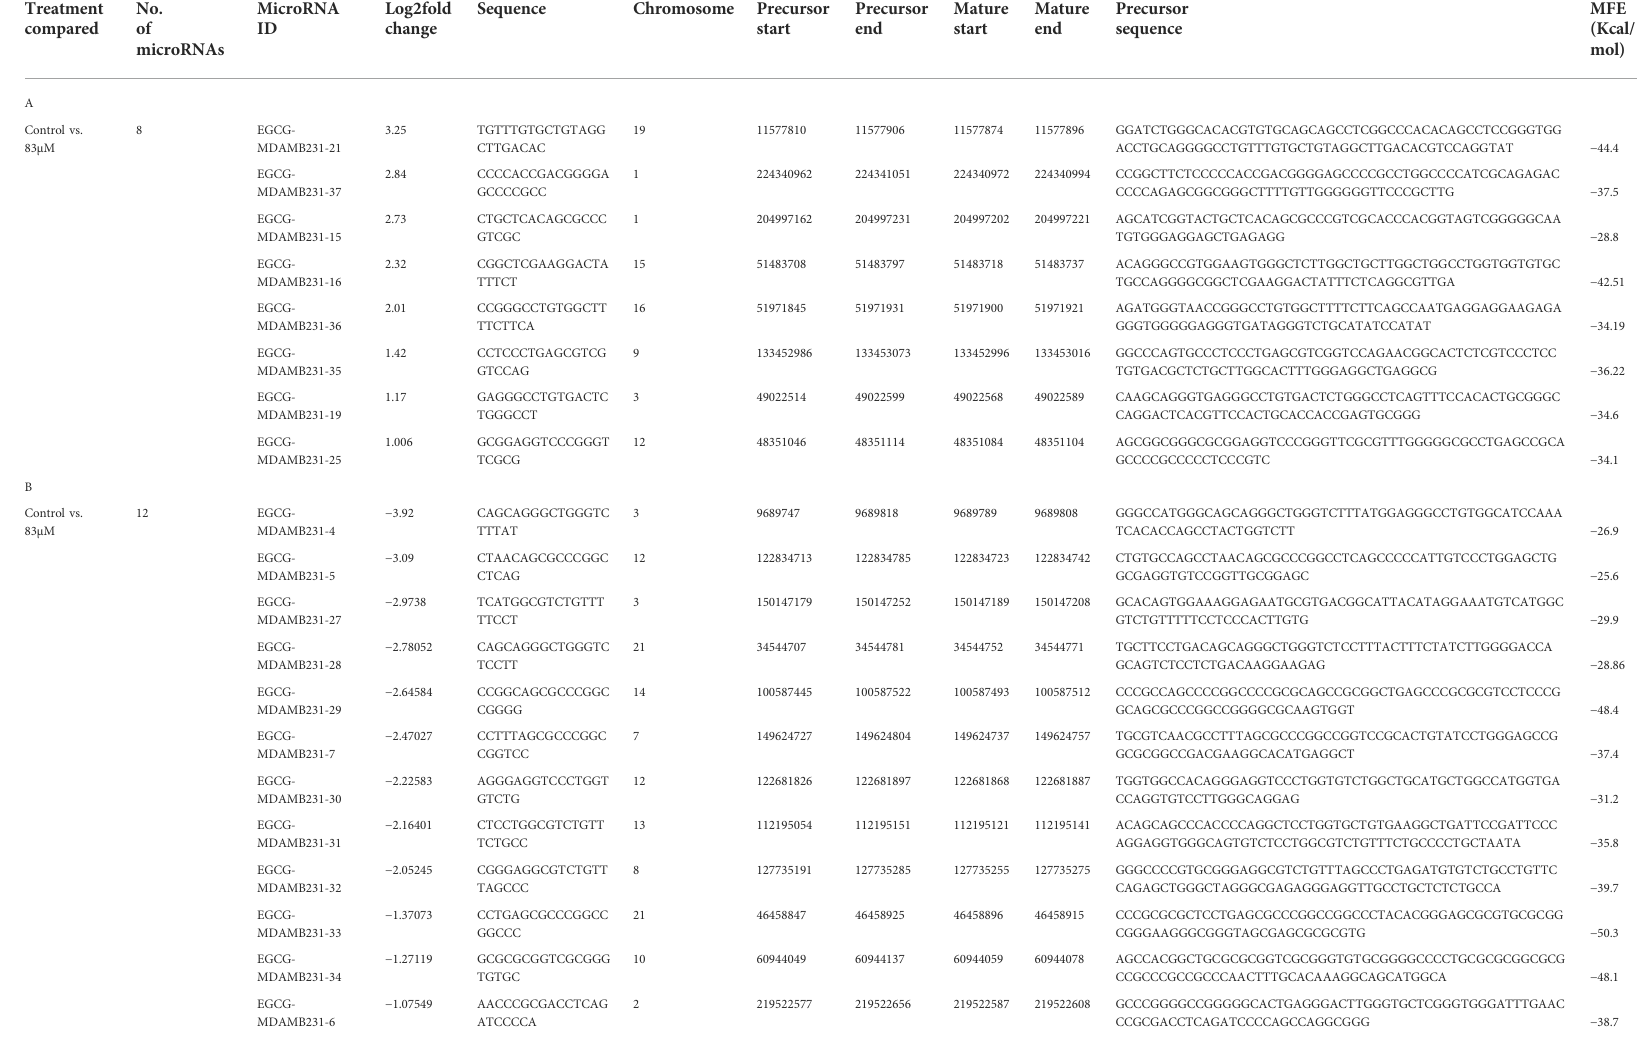
TABLE 3 A: Up-expressed putative novel microRNA sequences after 83 μ M EGCG treatment. B: Down-expressed putative novel microRNA sequences after 83 μ M EGCG treatment. Treatment compared